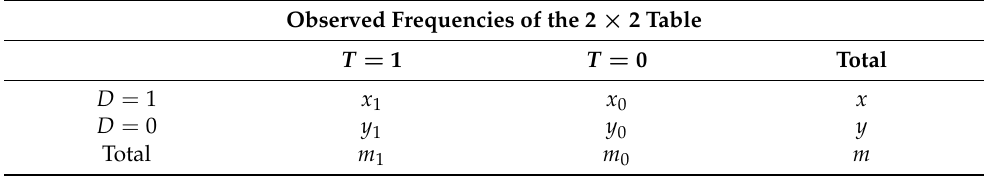
Table 1. Observed frequencies in the presence of complete